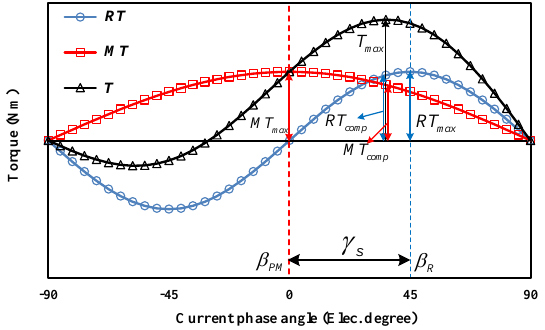
Figure 4. Diagram of torque component separation of a conventional IPM machine.